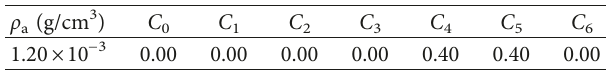
Table 6: Parameters of air and its EOS equation.